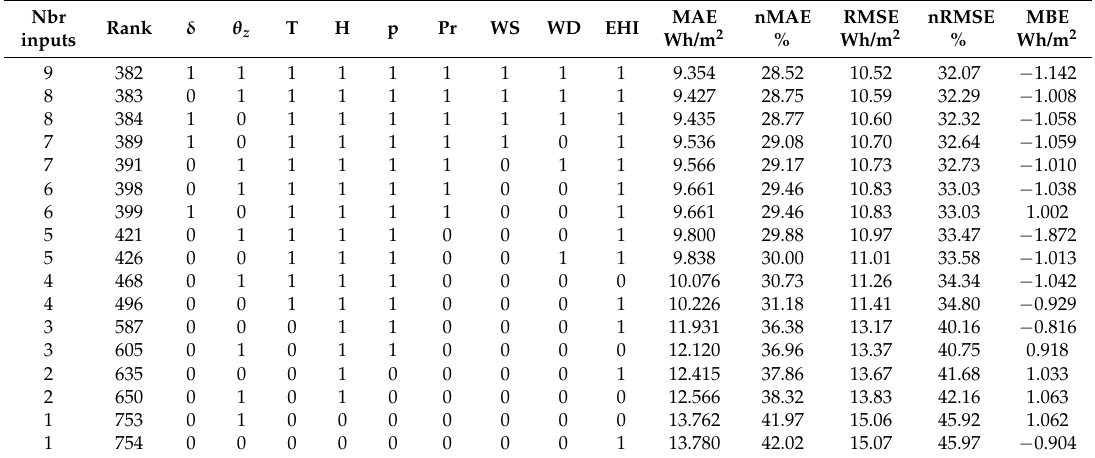
Table 4. Best configurations according to the number of inputs (without S) (Bouzareah site). (1 = present data, 0 = absent data).